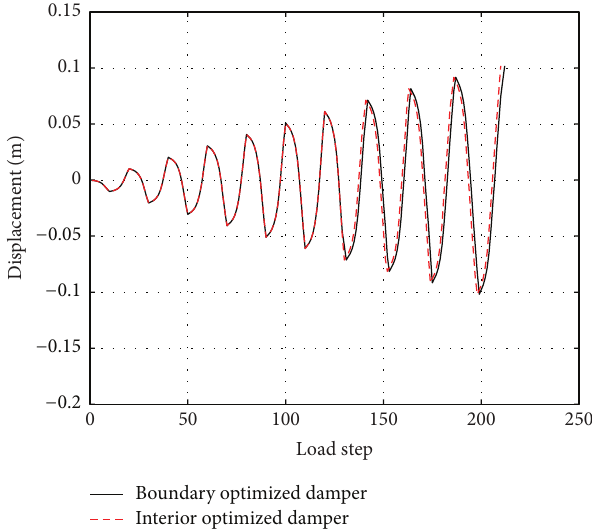
Figure 24: Comparison of displacement history in frame.